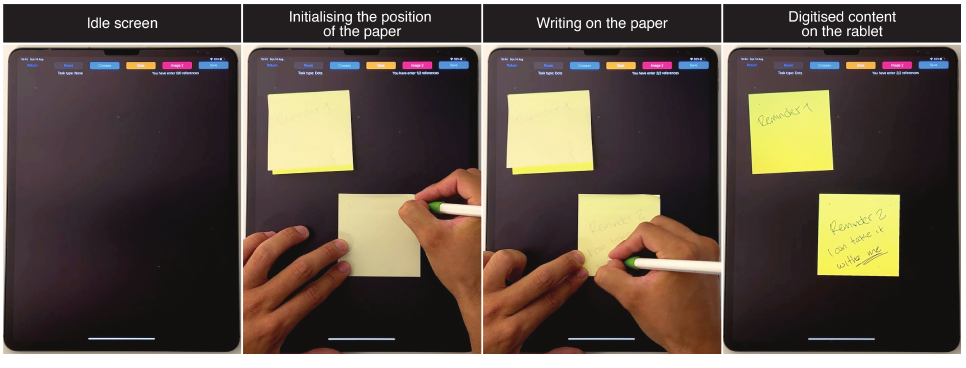
Figure 11. Sticky notes